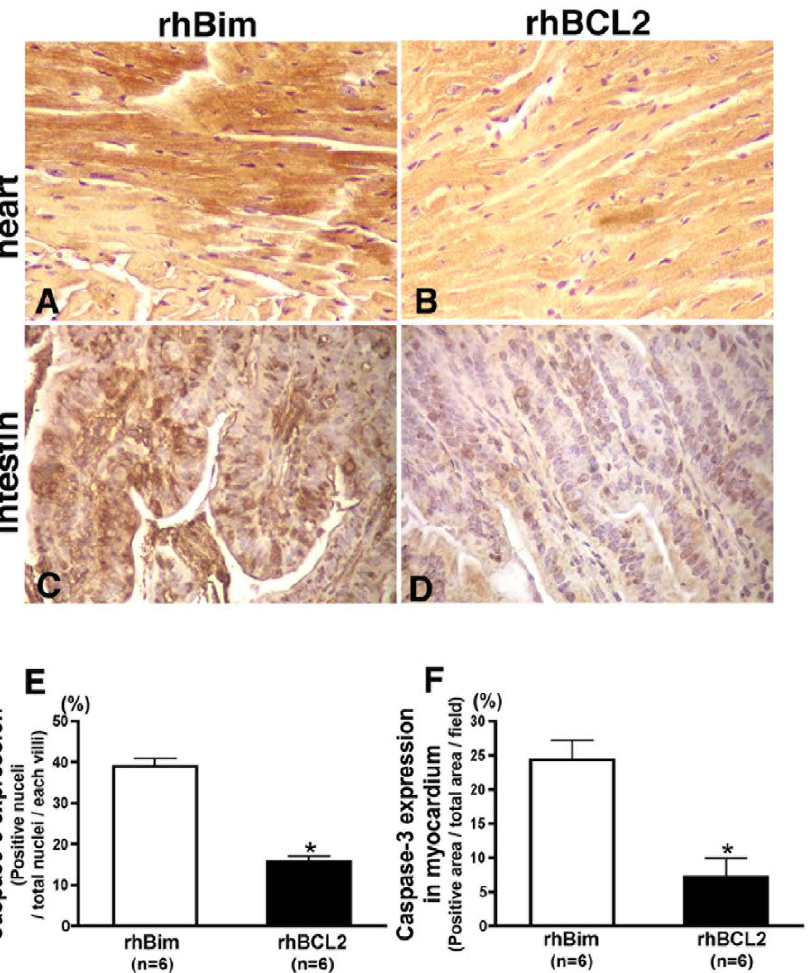
Figure 3. Treatment with rhBCL2 protein reduces cleaved caspase-3 in heart and intestine of mice following CLP. Mice were treated with a single i.p. injection of 1 m g rhBim (A, C) or 1 m g rhBCL2 (B, D) at 18 hours prior to CLP. Heart (A, B) or intestine (C, D) was stained for cleaved caspase with 3, 3 9 -diaminobenzidine (brown). Nuclei were stained with hematoxylin (purple). Original magnification is 400 6 . Panels E and F show quantitation of cleaved caspase-3 expression in myocardium (E) and intestinal villi (F) in mice treated with rhBim compared to those treated with rhBCL2. *p , 0.05.